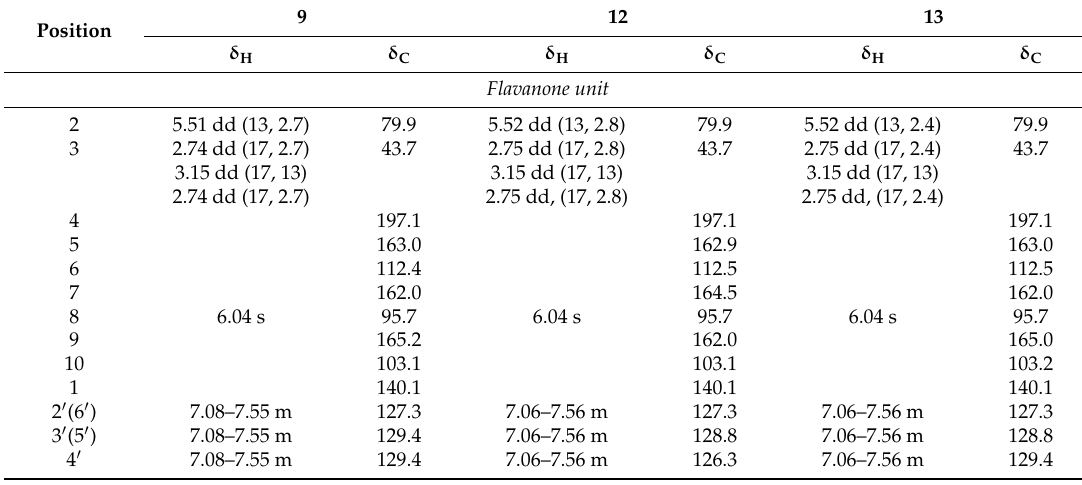
Table 1. NMR data of Compounds 9 , 12 , and 13 ( δ in ppm and J in Hz).